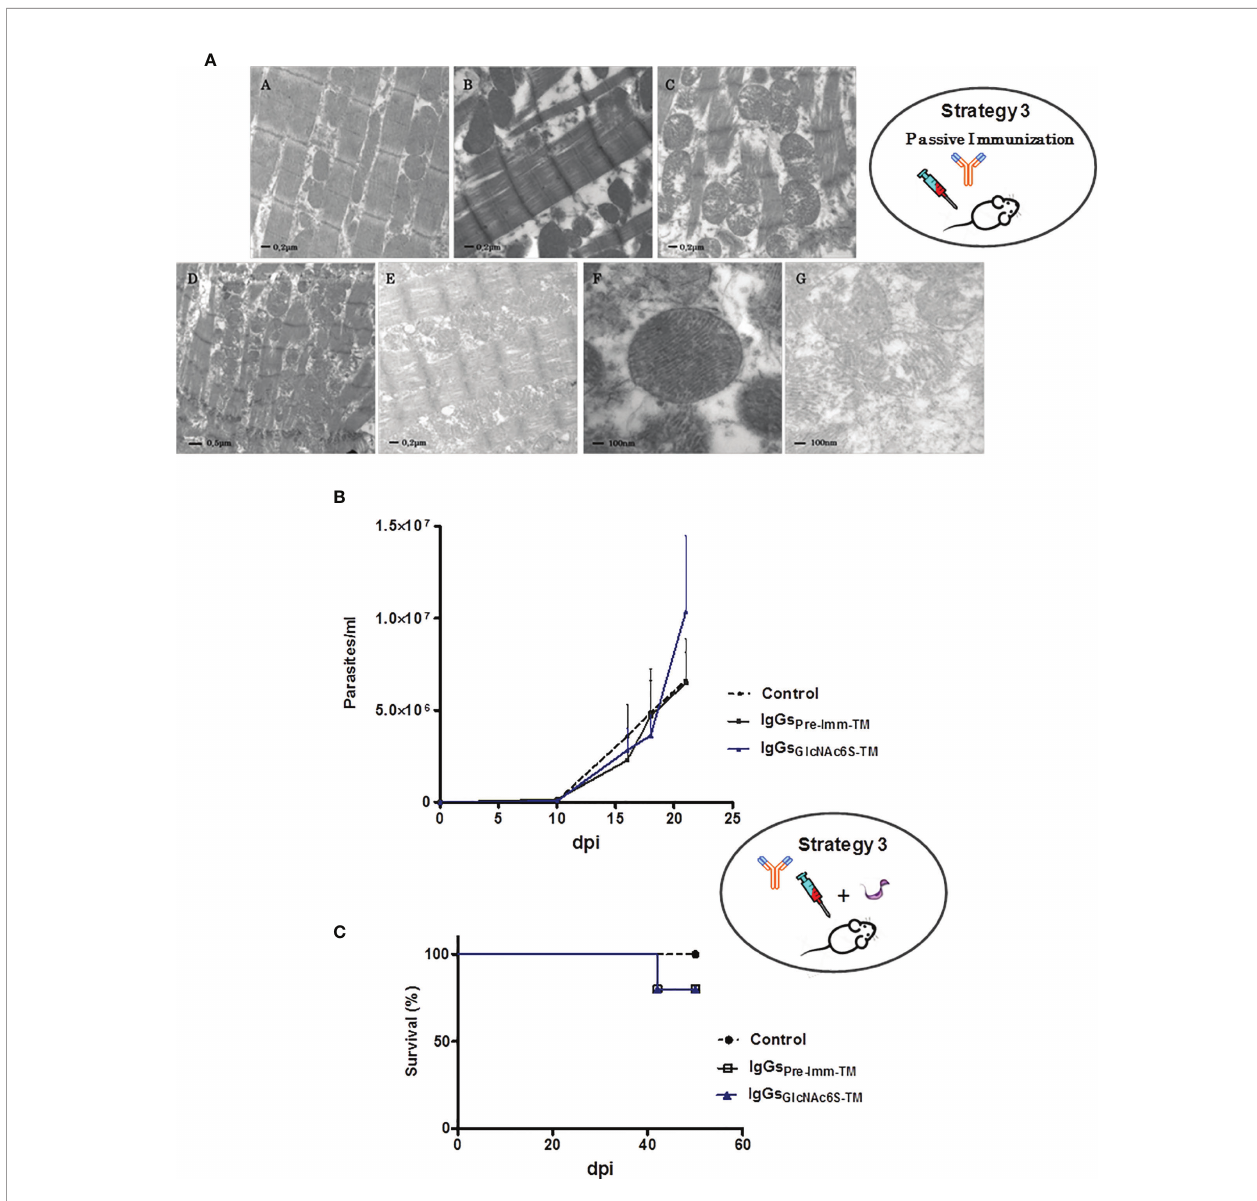
FIGURE 6 | Treatment of BALB/c mice by passive transference of puri fi ed IgG-GlcNAc6S in the presence or absence of T. cruzi sublethal challenge. (A) Ultrastructural alterations of cardiac muscle tissue in mice treated with puri fi ed mouse IgG-GlcNAc6S, in the absence of infection. The ultrastructural morphologic analysis was performed by electron microscopy of transmission. Ultramicrograph of cardiac tissue from control mice (A), IgG-pre-imm- TM , mouse treated with puri fi ed IgG-pre-imm from mouse sera (B); cardiac tissue of mice treated with puri fi ed IgG-GlcNAc6S, IgG-GlcNAc6S- TM (C – E). (A – C, E) (20,000×); in (D), (12000 ×). Mitochondria of cardiac tissue from IgG-pre-imm- TM (F) or IgG-GlcNAc6S-(G). In (F) and (G), (50,000×). Acute phase of infection from BALB/c mice, treated with IgG- GlcNAc6S after a sublethal dose of T. cruzi . (B) Parasitemia (parasite number/ml of peripheral blood) and (C) survival percentage (%) from control of infection and treated with IgG-pre-imm and IgG-GlcNAc6S ( n = 5 mice per group). The challenge was performed on day 1 from the experiment and the exogenous antibody transference via intraperitoneal administration was performed on days 2, 4, 6, 9, 12, and 17. Error bars indicate SD. Blue line, black line, and dotted black line represent IgG-BSA-GlcNAc6S- TM , IgG-pre-imm- TM , and control groups, respectively. The oval schemes in the upper and medium parts of the fi gure represent strategy 3 part of passive immunization and passive immunization followed by challenge with trypomastigotes,